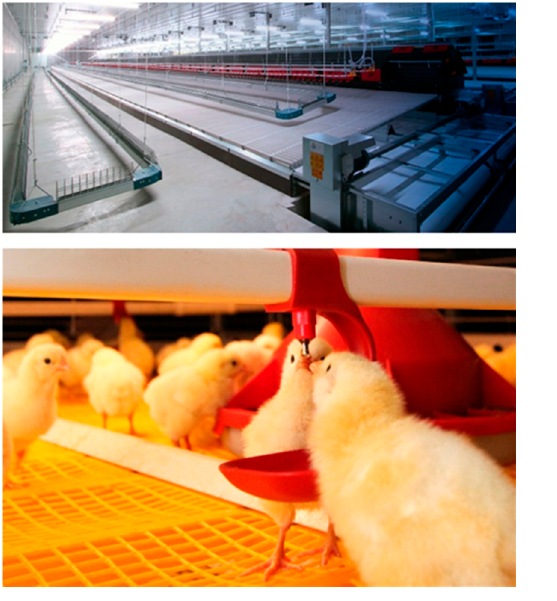
14 of 26 Figure 4. Automatic milking equipment (Source: LELY Industries N.V.). In chicken houses, advanced technologies such as automatic feeding and water sup- ply are commonly used (Figure 5a). In recent years, extensive research has been carried out to improve poultry production and comprehensive benefits [89]. Because of the struc- tural configuration of the cage production system, a variety of automated equipment has become a functional component of this system. A good example is the highly automated machine used to collect and sort egg layers (Figure 5b). Nonetheless, checking the health and welfare of chickens and optimizing the overall management of the hen house requires human intervention [90]. Currently, large chicken farms are equipped with the cloud- based data management system (CDMS), which can share real-time visual data on the performance and feeding conditions of chicken flocks in a given chicken farm with a num- ber of different chicken farms. This is conducive to the realization of scientific manage- ment [91]. An unmanned farm is committed to intelligent management, where intelligent equipment can be used to replace repetitive and frequent manual operations, such as as- sessing animal status, eliminating dead chickens, maintaining indoor environmental con- ditions (dry cleaning, wet washing, fertilizer removal, ventilation and sanitary treatment), inoculation, trade-offs, selection of floor eggs, sorting and packaging [92,93]. A cloud plat- form can be established as the core of the system to achieve unmanned management. As a part of an auto-work equipment system, intelligent fixed equipment plays an important role in accurate management and control, especially intelligent monitoring equipment. Intelligent fixed equipment can replace the repeated and tired work of human